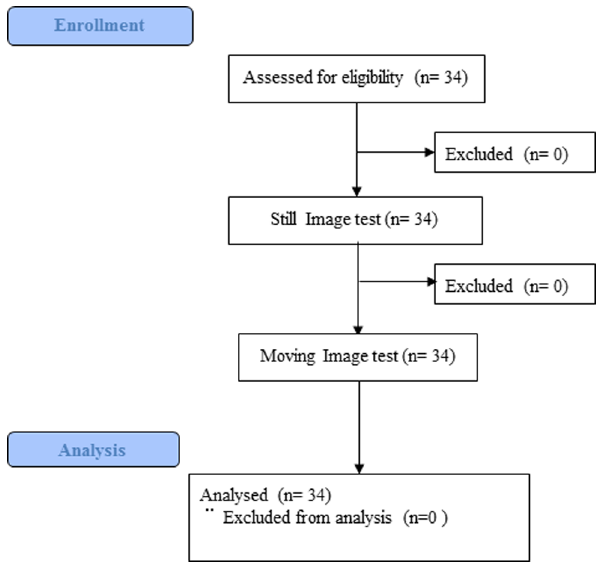
Figure 1. Flow chart of enrollment and analysis records.